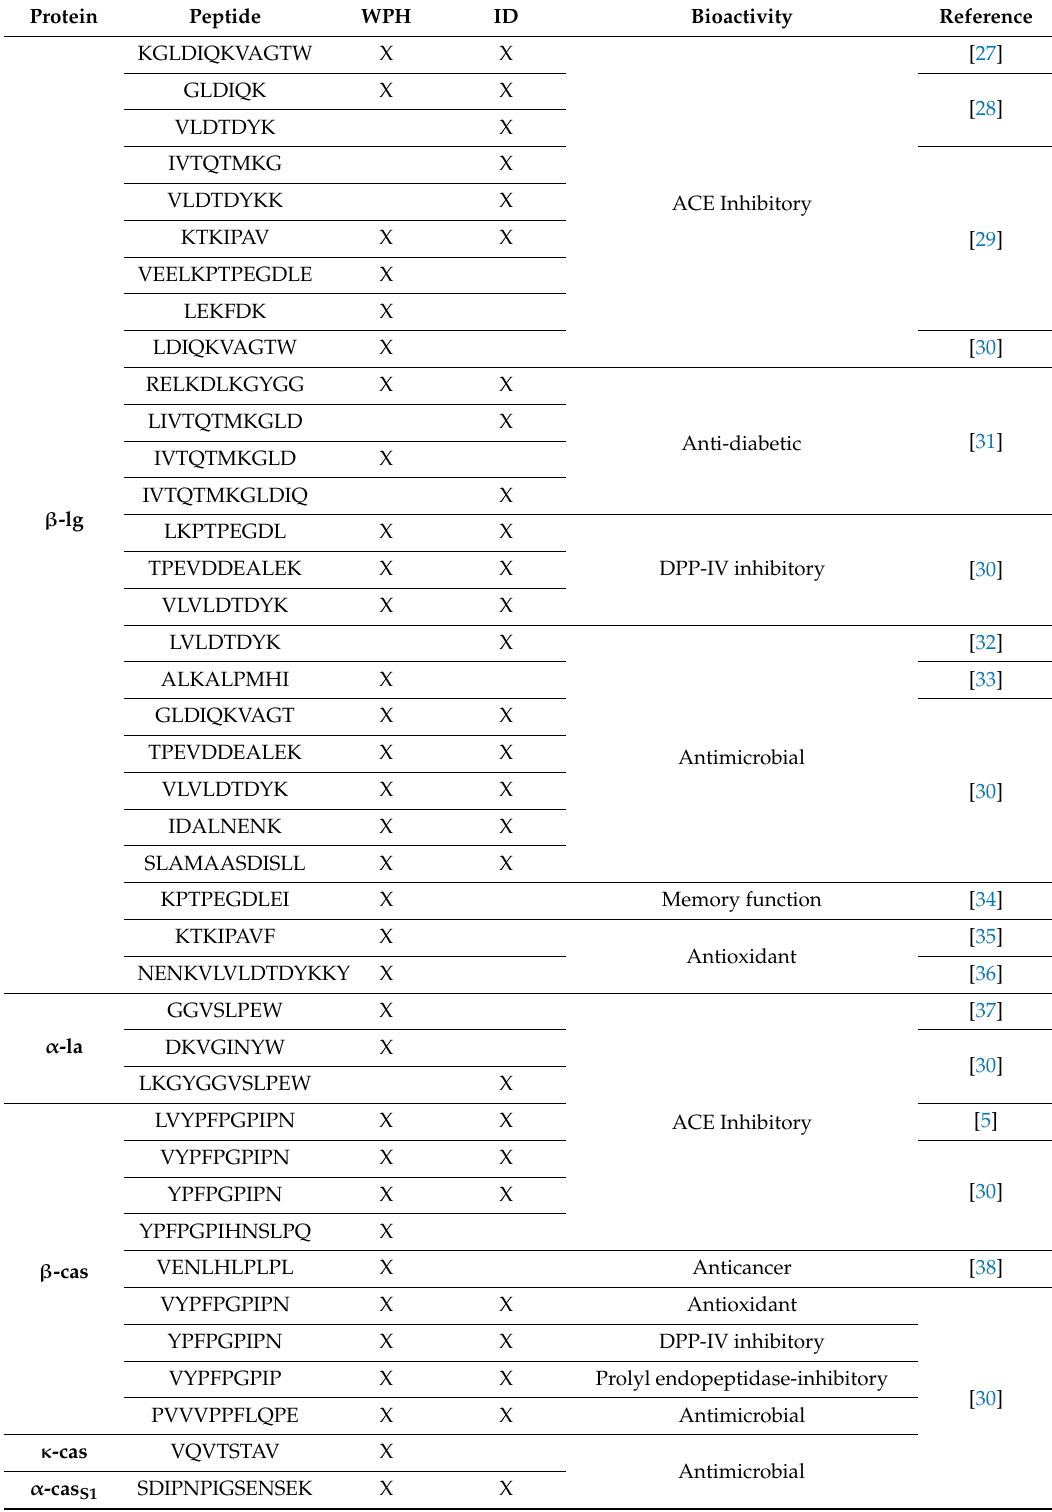
Table 2. Health benefits reported in the literature for peptides released from undigested (WPH) and intestinal digested (ID) whey protein hydrolysates following simulated absorption studies in a UC: the proteins considered are β -lactoglobulin ( β -lg), α -lactalbumin ( α -la), β -casein ( β -cas), κ -casein ( κ -cas), and α S1 -casein ( α -cas S1 )